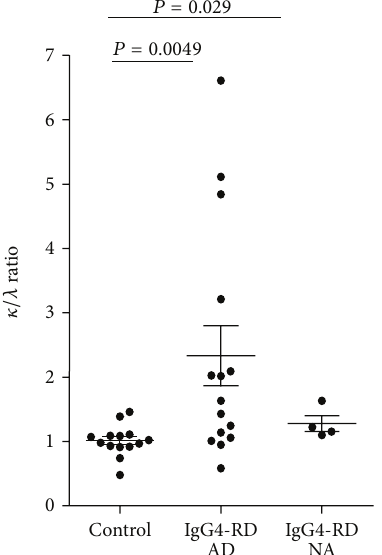
Figure 2: Kappa/lambda serum FLC ratio in patients with IgG4- RD. Comparison of serum free 𝜅 and 𝜆 light chains ratio in controls, IgG4-RD patients with active disease (IgG4-RD AD) and nonactive disease (IgG4-RD NA). Median and interquartile ranges are shown.